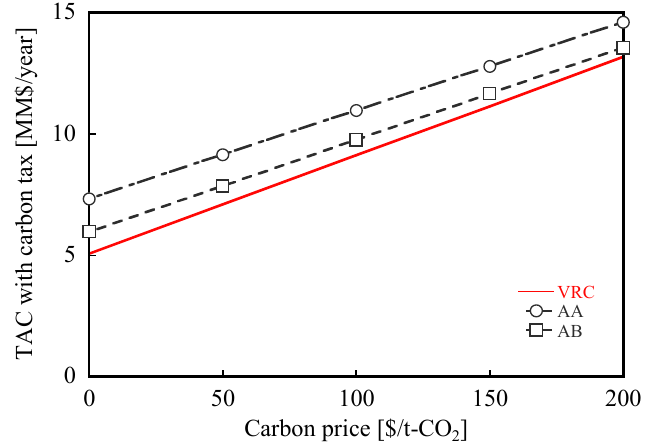
Figure 8. TACs with the carbon tax for different cases of the membrane-separation process compared to VRC .